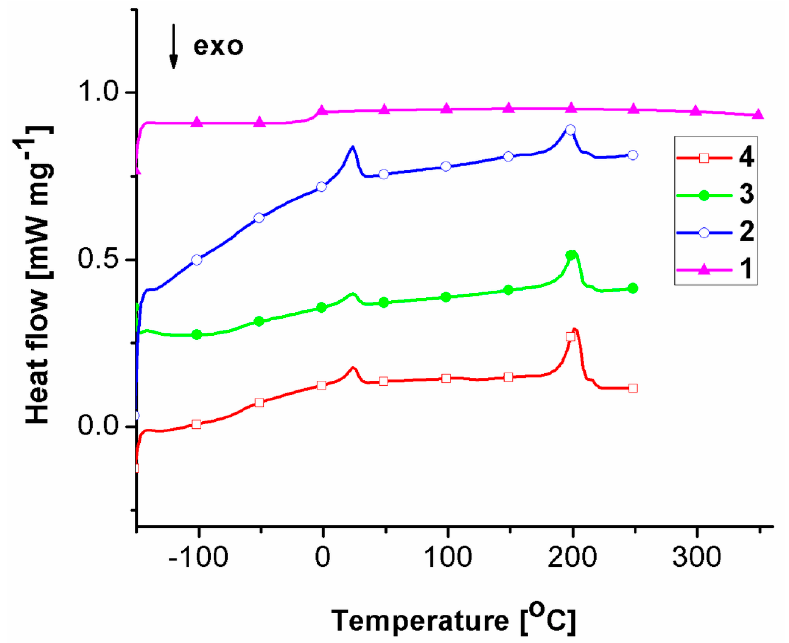
Figure 2. DSC second scans of the studied samples.